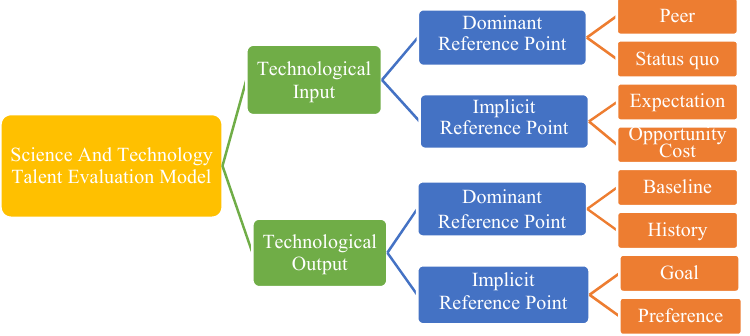
Figure 3. ‘dominant-implicit’ reference points.